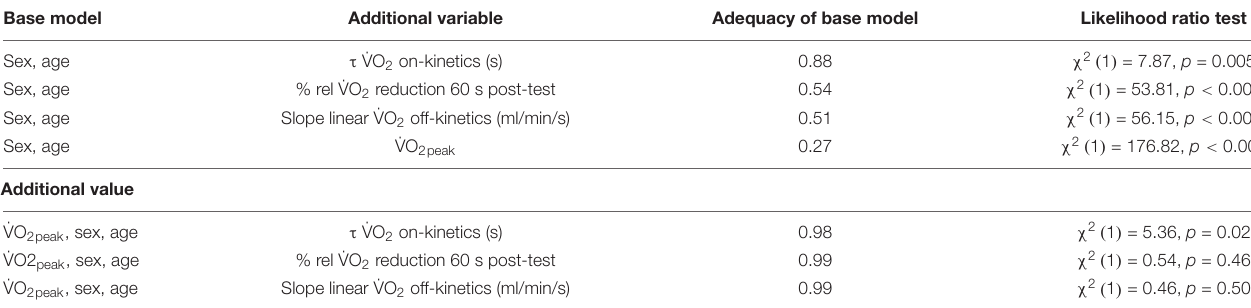
TABLE 3 | Predicting disease severity (NYHA functional class) using ˙VO 2 kinetic